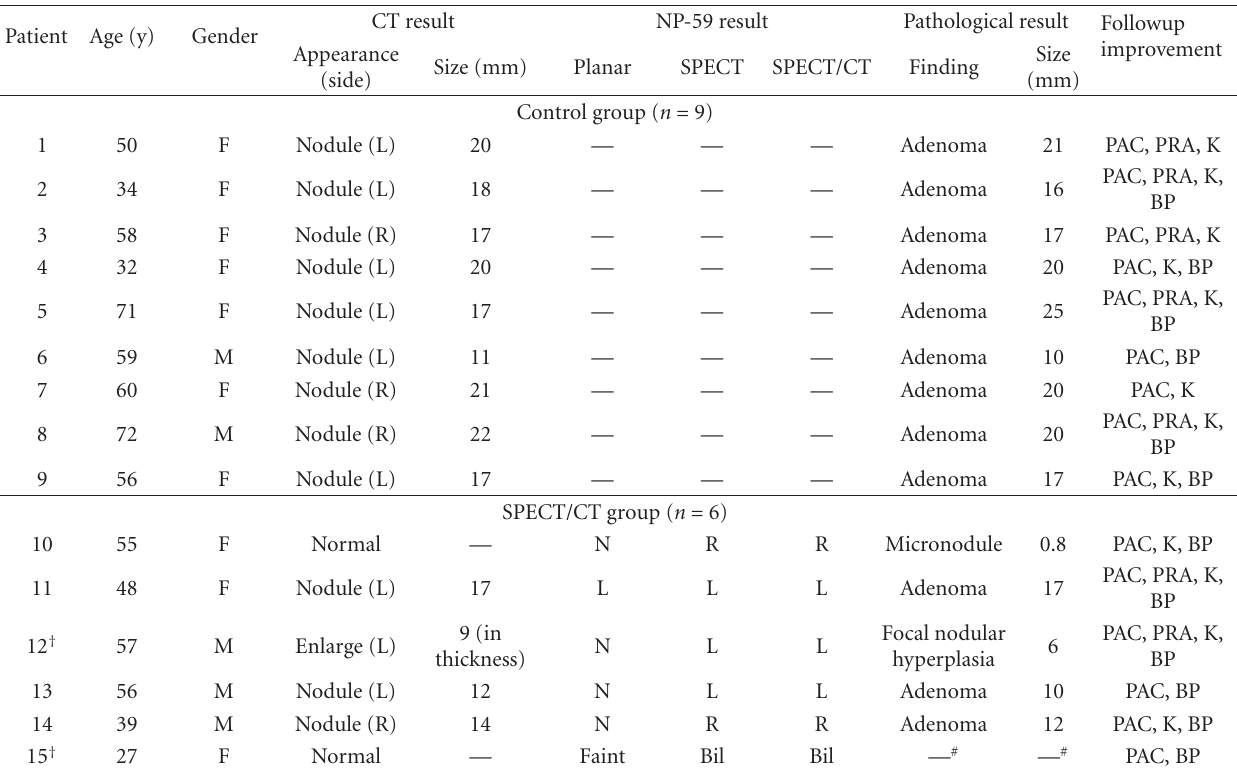
Table 2: Imaging and pathological data of study